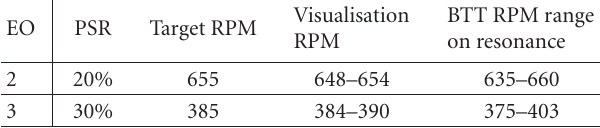
Table 9: Amplitude validation test parameters.